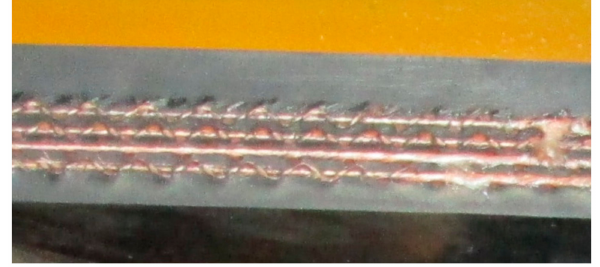
Figure 2. The tested conveyor belt in a